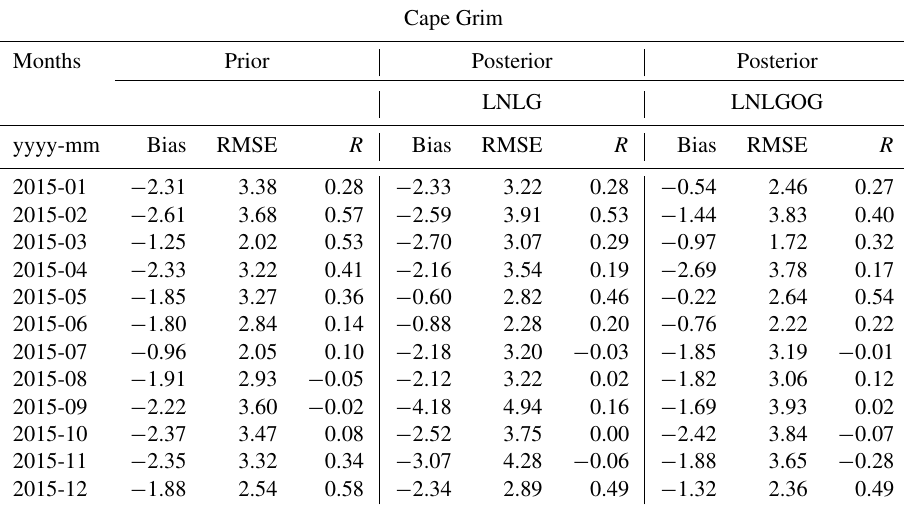
Table H4. Analysis of the residual between CMAQ prior and posterior simulations and the Cape Grim site for 2015: averaged bias, RMSE and Pearson’s coefficient ( R ).